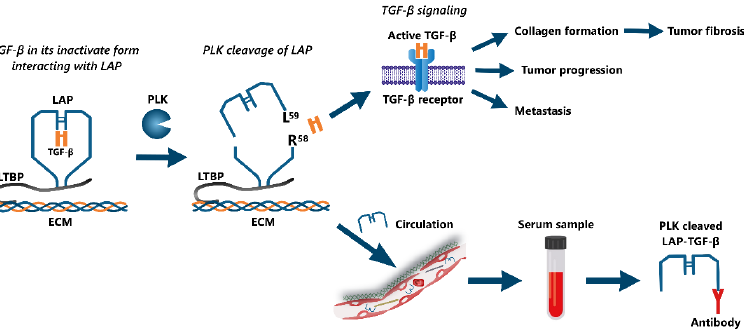
Figure 1. Illustration of plasma kallikrein (PLK)-mediated TGF- β activation: TGF- β in its latent state in complex with latency-associated peptide (LAP) (LAP-TGF- β ) is bound to the extracellular matrix (ECM) via latent TGF- β binding protein (LTBP). PLK cleaves LAP between 𝑅 58 and 𝐿 59 , resulting in the release of active TGF- β and the PLK-cleaved LAP-TGF- β fragment. The active TGF- β will induce multiple biological functions, including tumor progression, metastasis, and collagen for- mation, leading to tumor fibrosis. The PLK-cleaved LAP-TGF- β fragment is released into circula- tion, and as a result, becomes detectable in serum and plasma samples through antibody binding.